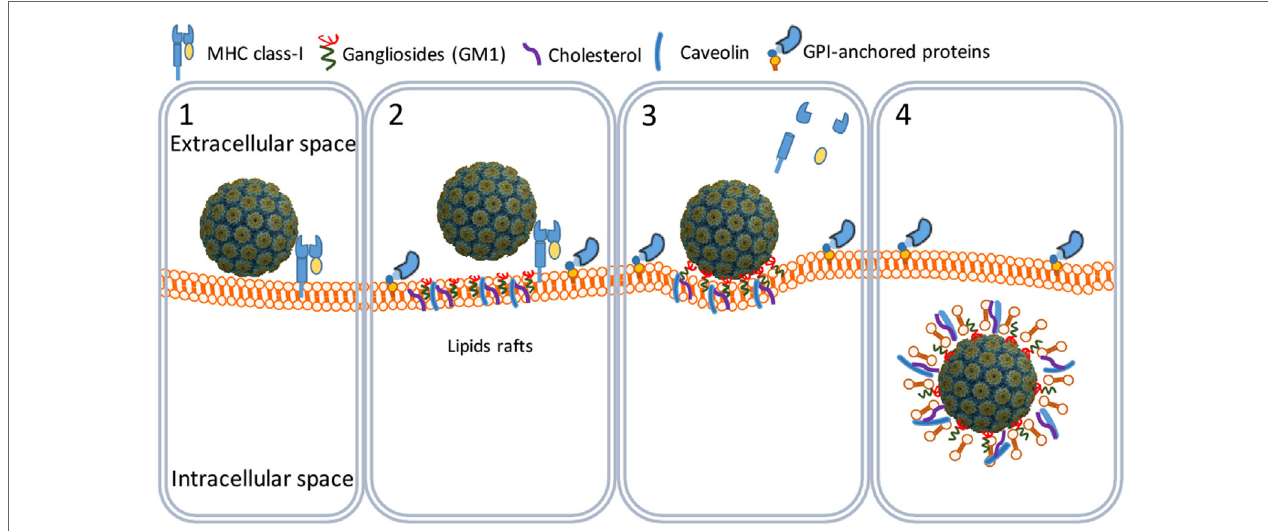
FigURe 2 | SV40 cell attachment and internalization. SV40 particles attach to the cell surface by binding to major histocompatibility class I molecules (1) that shuttle the virus particles to GM1-rich lipid rafts (2). The particles bind GM1 and induce the formation of caveolar endocytic vesicles (3) and get into the cytosol through an active translocation mediated by glycosylphosphatidylinositol (GPI)-anchored proteins